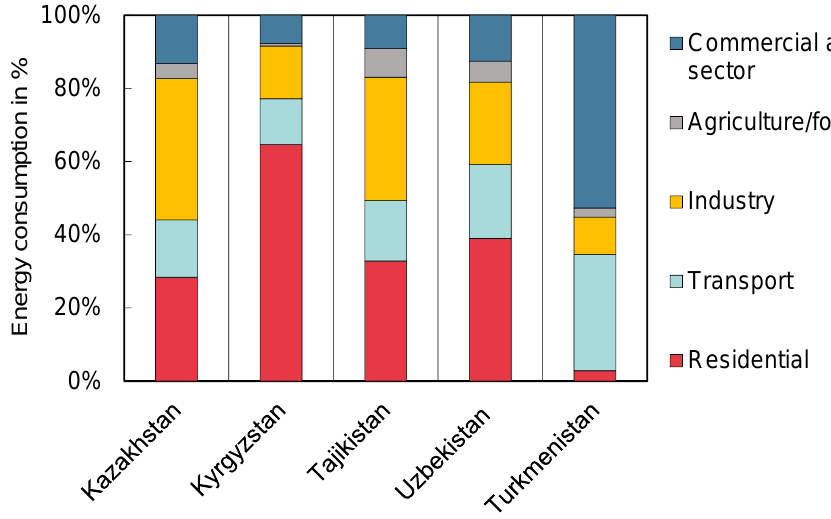
Figure 1. Total final energy consumption by sectors in Central Asia in 2018 (data according to [16]). Because of their geographical location, most of the central Asian countries experience a cold climate with a heating period duration of between six and nine months. In